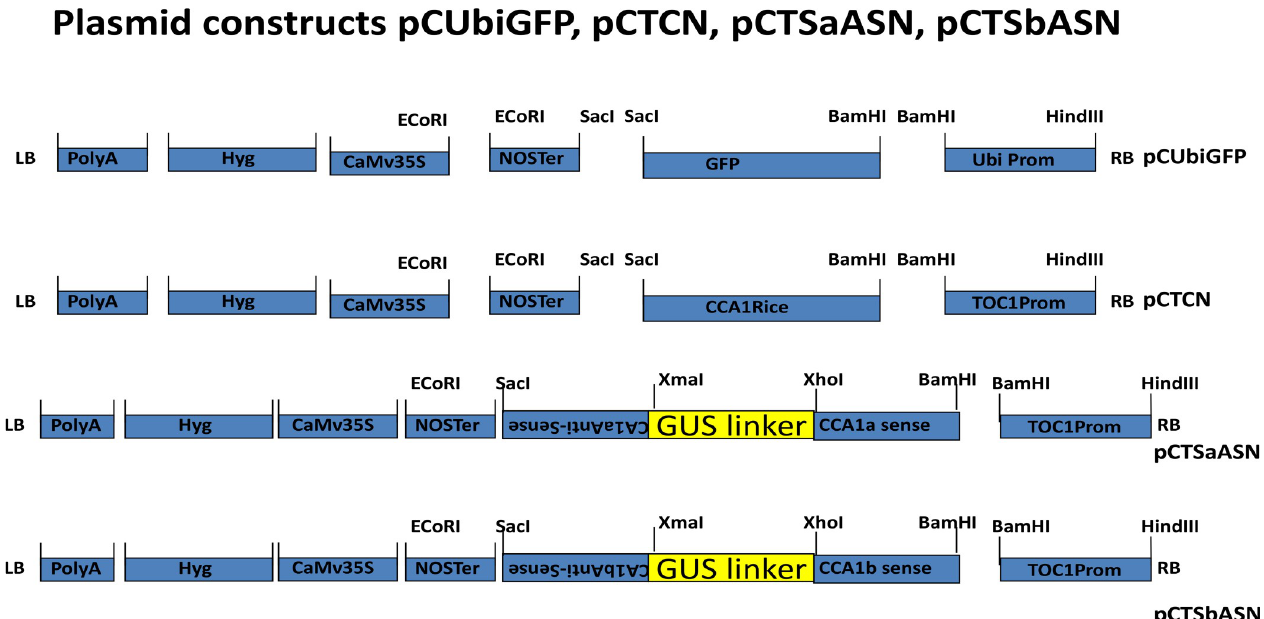
Fig 2. Plasmid constructs employed in the present investigation. The gfp gene under the control of Ubiquitin promoter ( pCUbiGFP ). One over expression cassette pCTCN designated as construct A having TOC1 : CCA1 : NOS was generated and two additional RNAi constructs, namely, pCTSaASN (B) and pCTSbASN ( C) for repression of circadian clock genes have been made by cloning sense and antisense part of the CCA1 gene ( a & b ) linked with GUS linker in pCAMBIA1300 under the control of TOC1 promoter. Gene cassettes cloned in T-DNA region of binary vector pCAMBIA1300 LB- Left border, RB- Right Border, CCA1 - Circadian Clock Associated, TOC1 PRO- TIMING OF CAB EXPRESSION 1 PROMOTER, The CCA1a and CCA1b sense and antisense fragments for making the two RNAi constructs pCTSaASN and pCTSbASN were designed by choosing 400 bp of 5‘region of CCA1a gene and 395 bp of 3‘region of CCA1b gene, CaMV35S -Cauliflower Mosaic Virus 35 S Promoter, NOS Terminator- Nopaline synthase terminator.